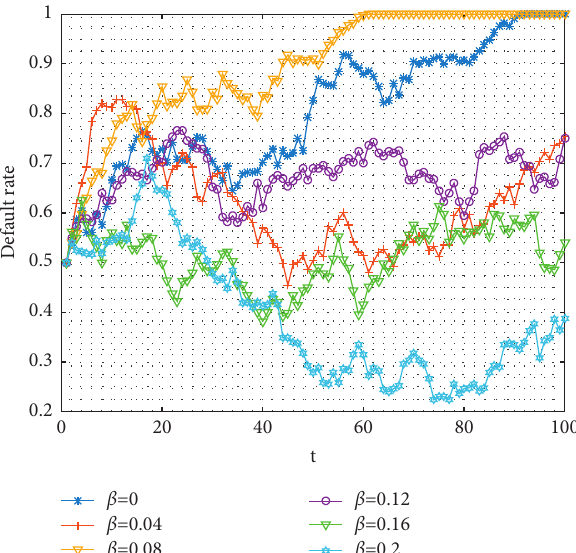
Figure 6: The effect of the punishment mechanism on the spread of default behavior in a scale-free network.